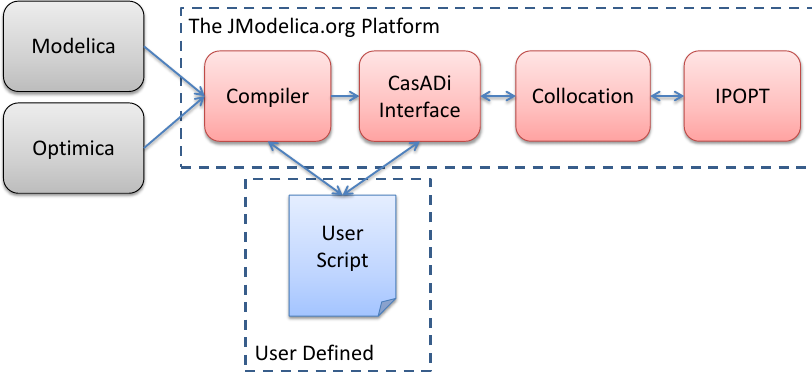
Figure 2. The dynamic optimization framework of the JModelica.org platform. The problem is formulated using Modelica and Optimica, which is then transferred to CasADi Interface by the JModelica.org compiler. CasADi Interface is a symbolic interface between the compiler, user, and collocation algorithm. After collocation, the problem is finally solved by